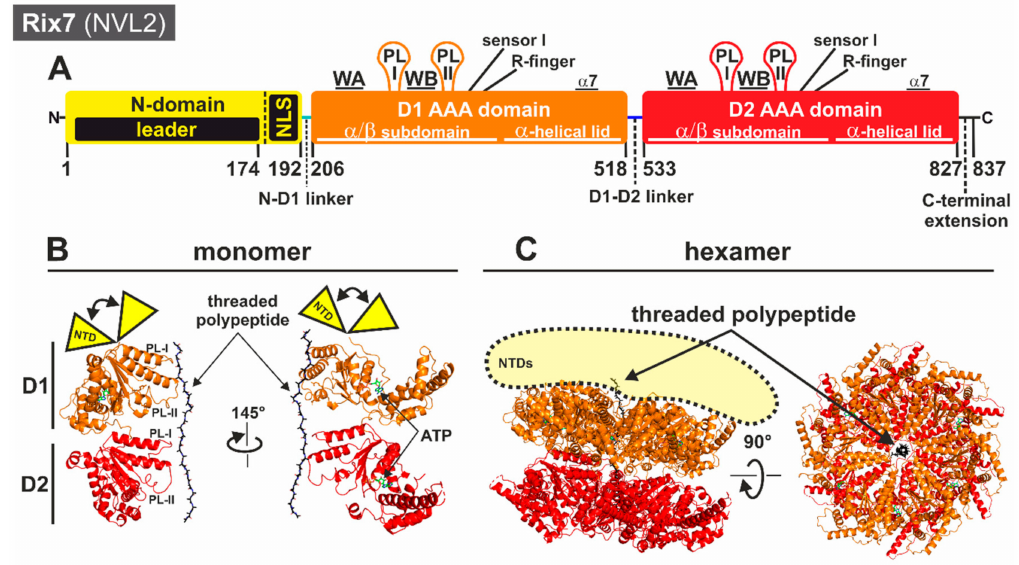
Figure 4. Domain organization and structure of the AAA-ATPase Rix7. ( A ) Rix7 contains two AAA modules D1 and D2 and an N-terminal domain per monomer. Annotation of the amino acid positions refers to the yeast proteins. The Rix7 NTD contains a nuclear localization sequence (NLS) that recruits the protein to the nucleus. A more detailed depiction of the Rix7 domain organization can be found in [68]. ( B , C ) Pore loops in each AAA module contain residues that form the inner lining of the central channel and are involved in the translocation of a threaded substrate [67]. The NTD is proposed to be dynamic and flexible and was not clearly localized in the structure of the substrate-bound C. thermophilum Rix7 complex (PDB ID: 6MAT). WA: Walker A motif. WB: Walker B motif. PL-I: Pore